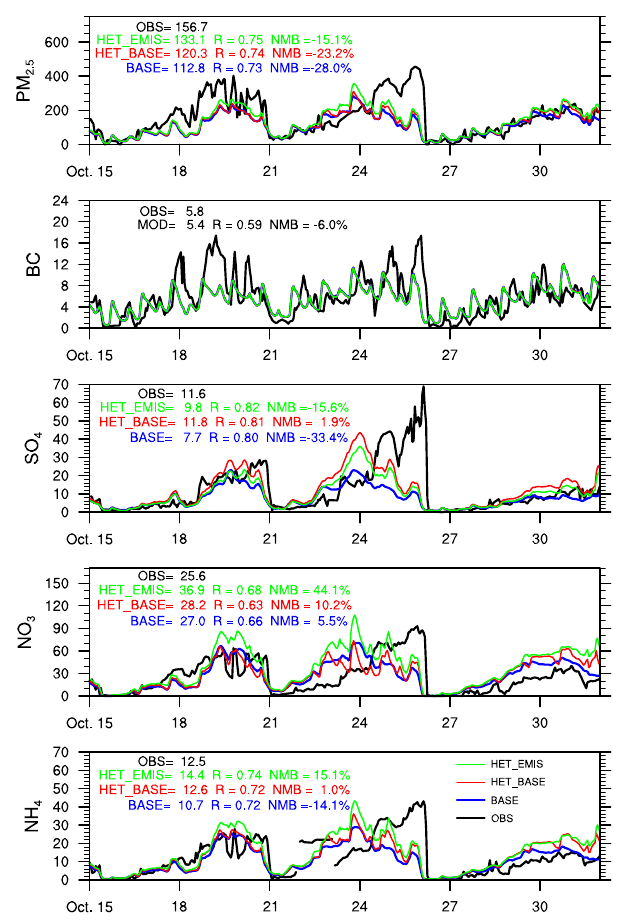
Figure 6. Time series of observed (OBS) and simulated (BASE, HET_BASE, HET_EMIS) hourly PM 2 . 5 and PM 1 species (µgm − 3 ) including black carbon (BC), sulfate (SO 4 ), nitrate (NO 3 ), and ammonium (NH 4 ). Descriptions of model scenarios are given in Table